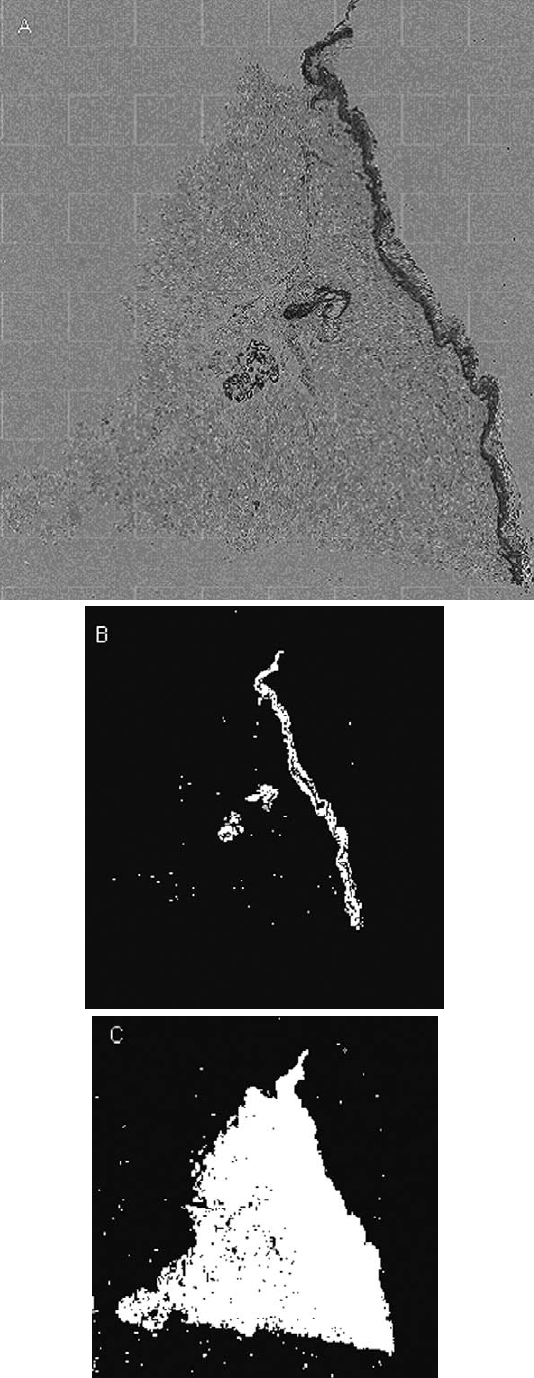
Fig. 4. De-magnified image of a CK stained tissue section (A). The architecture of immunopositive (B) and “other” tissue elements (C) is represented in monochrome